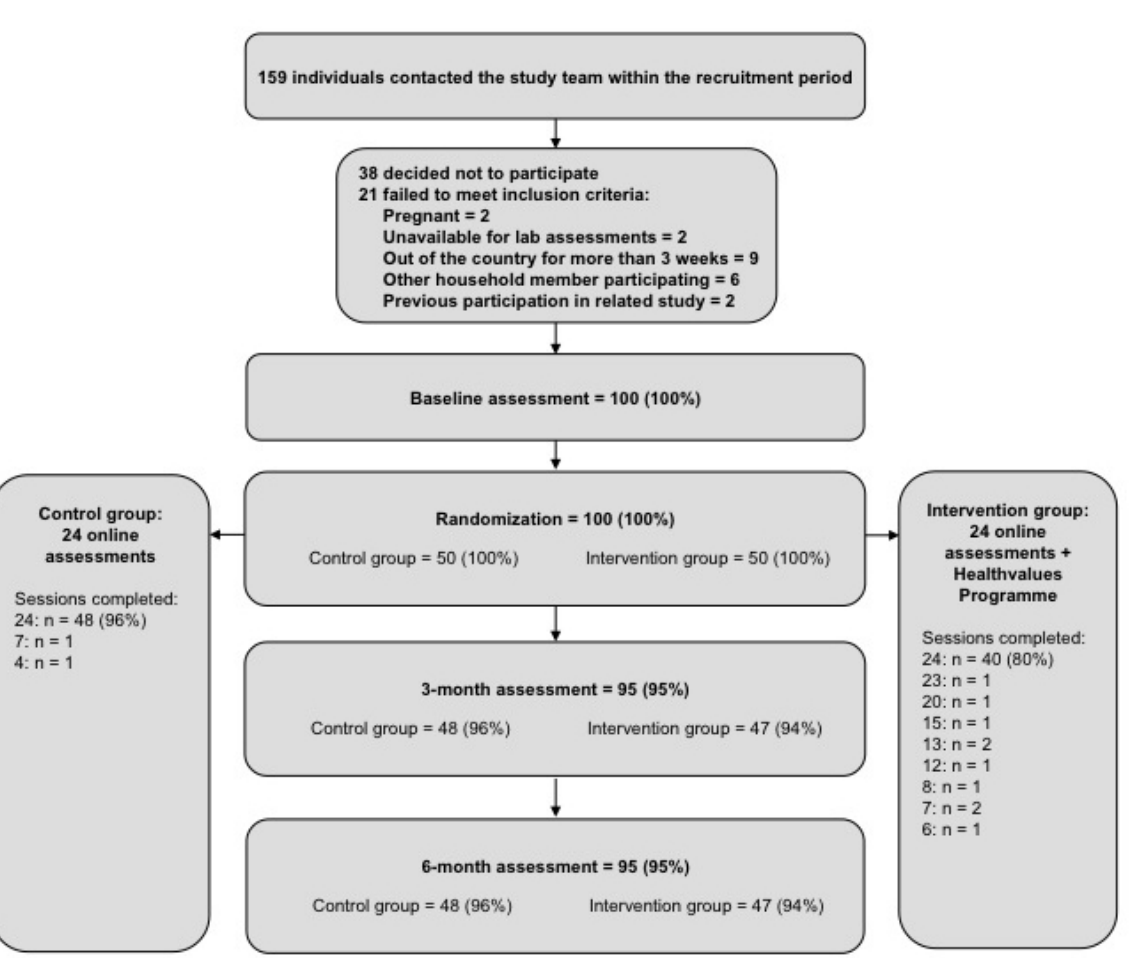
Figure 1. Flow of participants through the